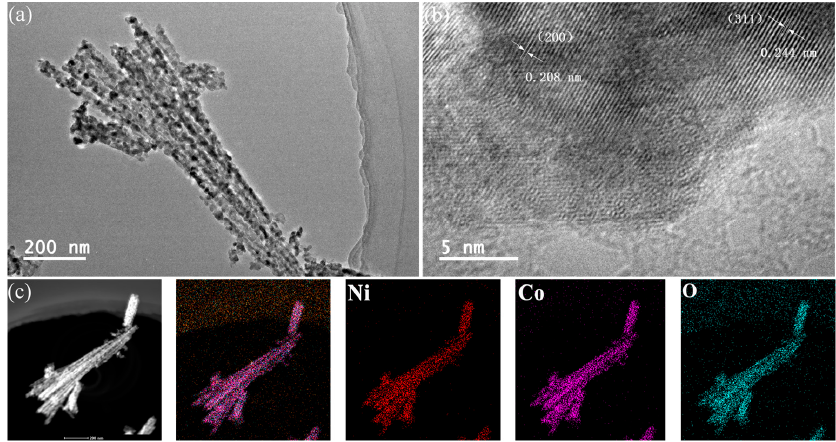
Figure 4. ( a ) TEM; ( b ) HRTEM and ( c ) elemental-mapping images of Ni 0.3 Co 0.7 O.